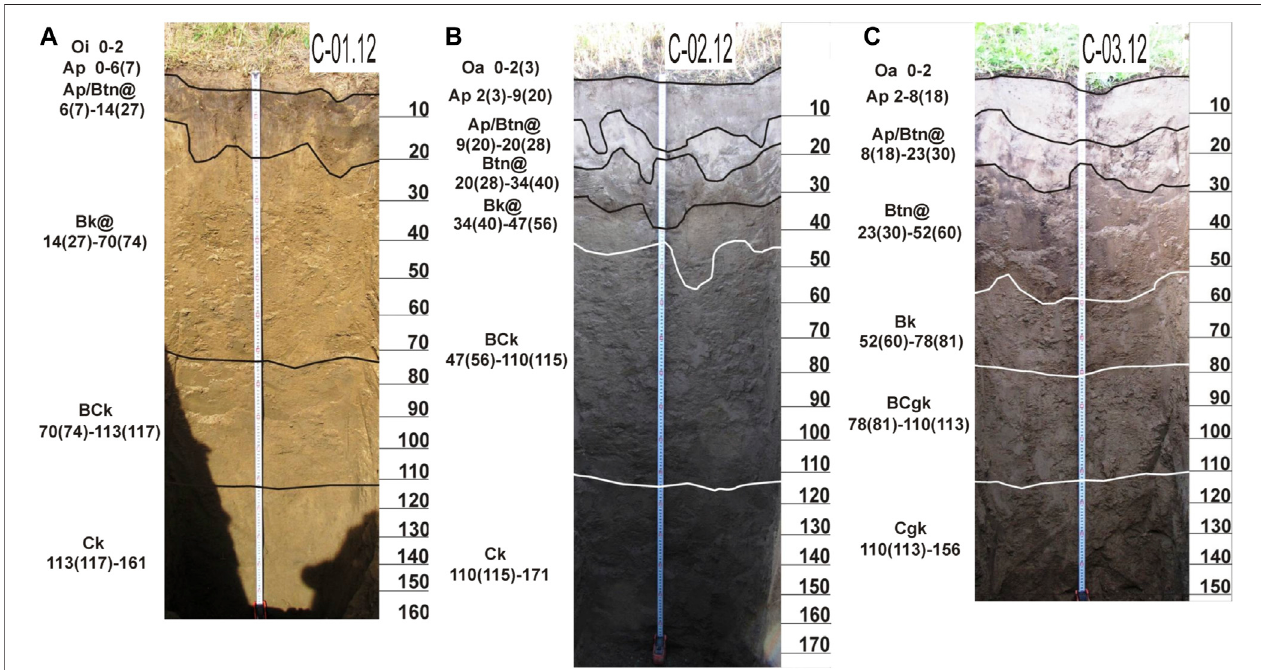
FIGURE 6 | Horizonation of soil pro fi les studied at the Churapcha site: (A) top of byllar, pit C-01-12; (B) slope of byllar, pit C-02-12; and (C) microlow between byllars, pit C-03-12.